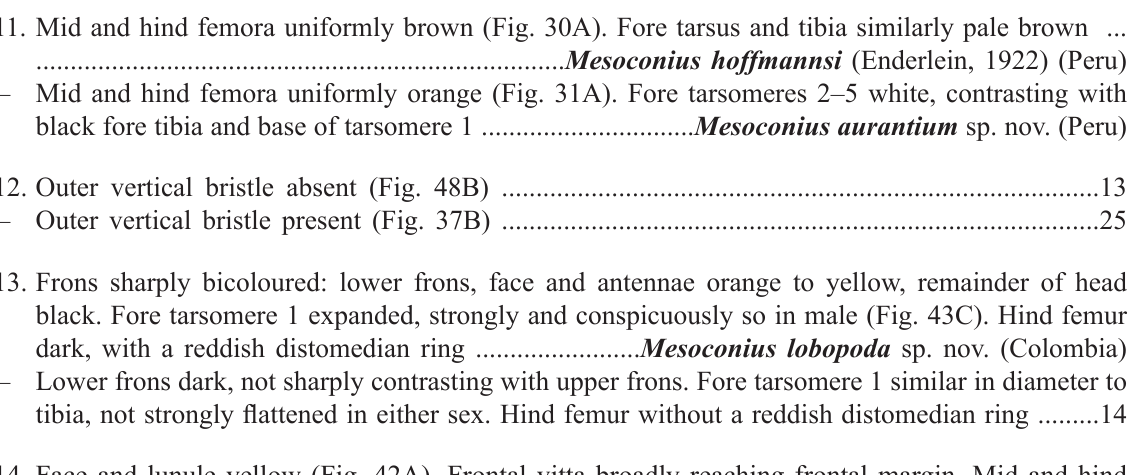
with a single incomplete ring ...................... Mesoconius braueri (Hennig, 1935) (Venezuela)